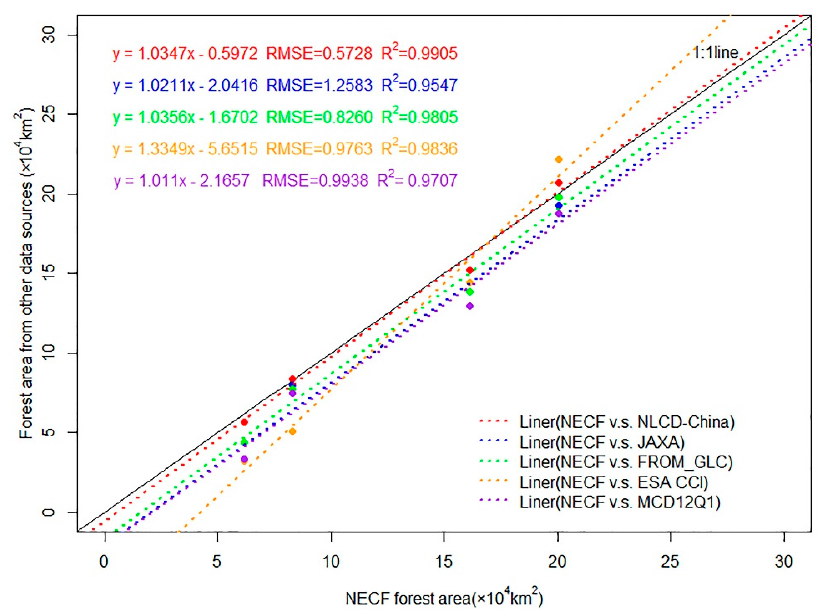
Figure 12. Uncertainties of forest cover estimation at the provincial level in 2010.